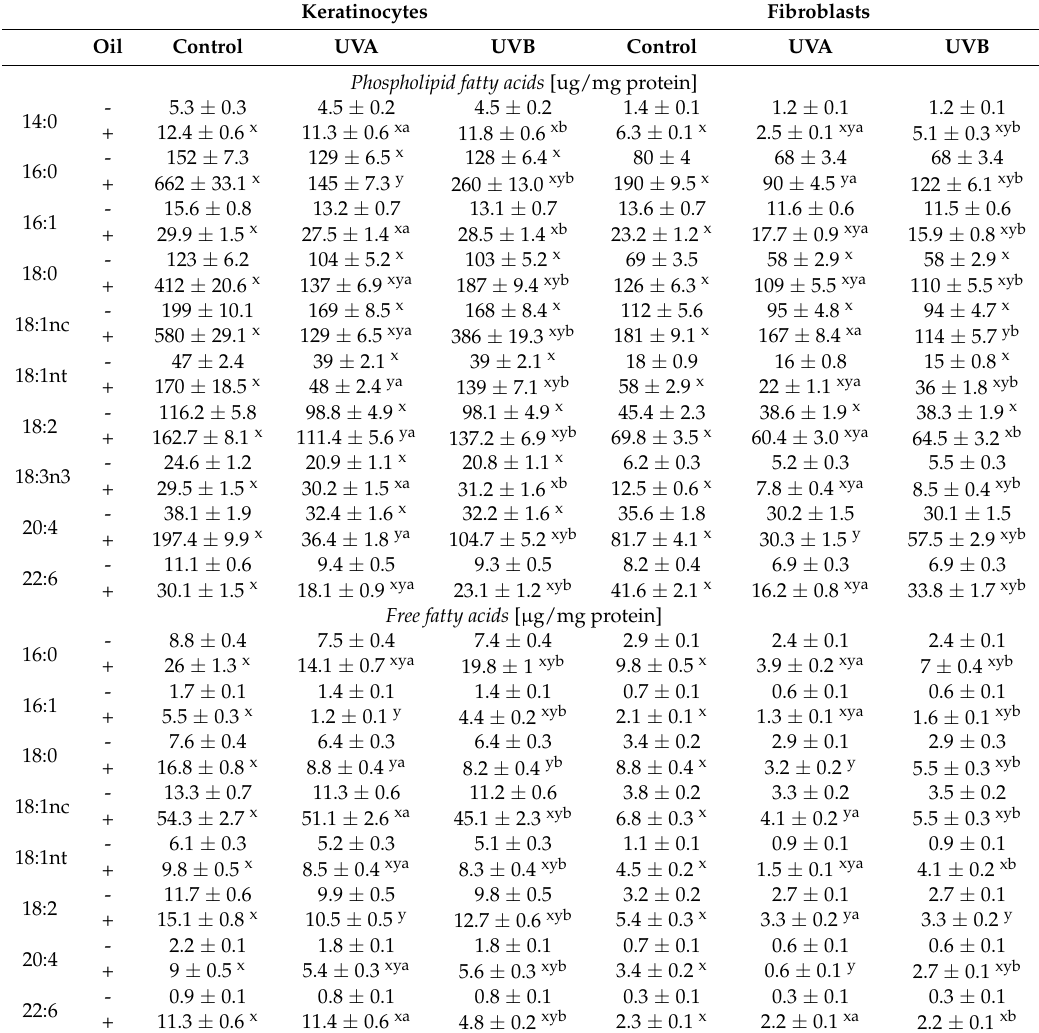
Table 4. The level of phospholipid and free fatty acids in keratinocytes and fibroblasts after exposure to UVA (30 J/cm 2 and 20 J/cm 2 ) and UVB radiation (60 mJ/cm 2 and 200 mJ/cm 2 , respectively) and sea buckthorn seeds oil (500 ng/mL)